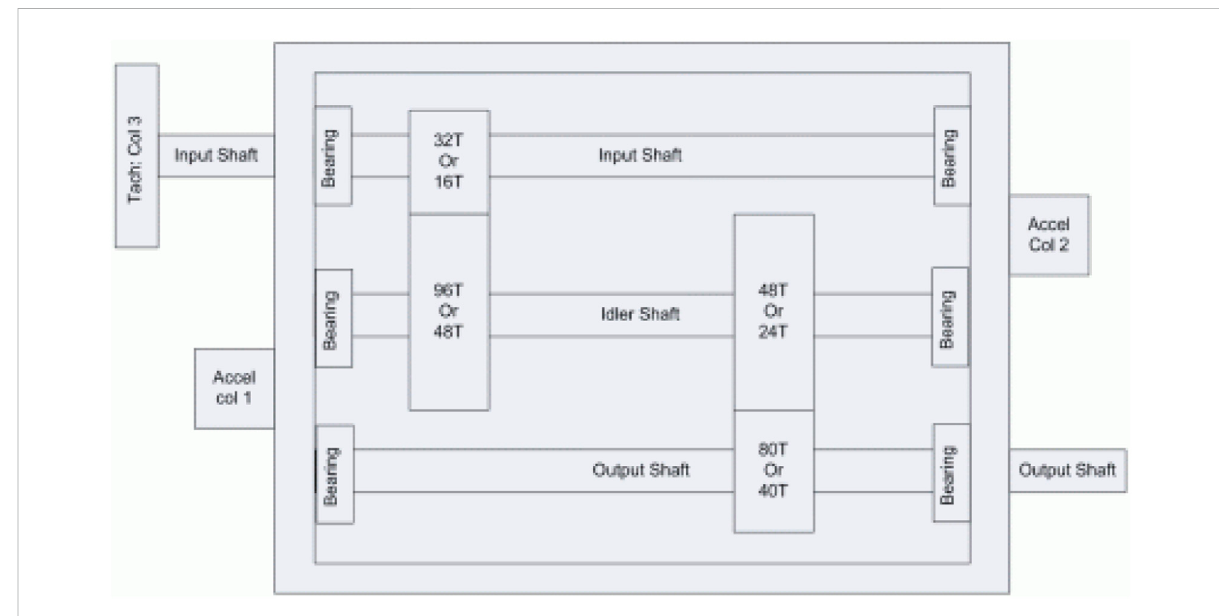
FIGURE 7 A schematic representation of the PHM 2099 testbed.